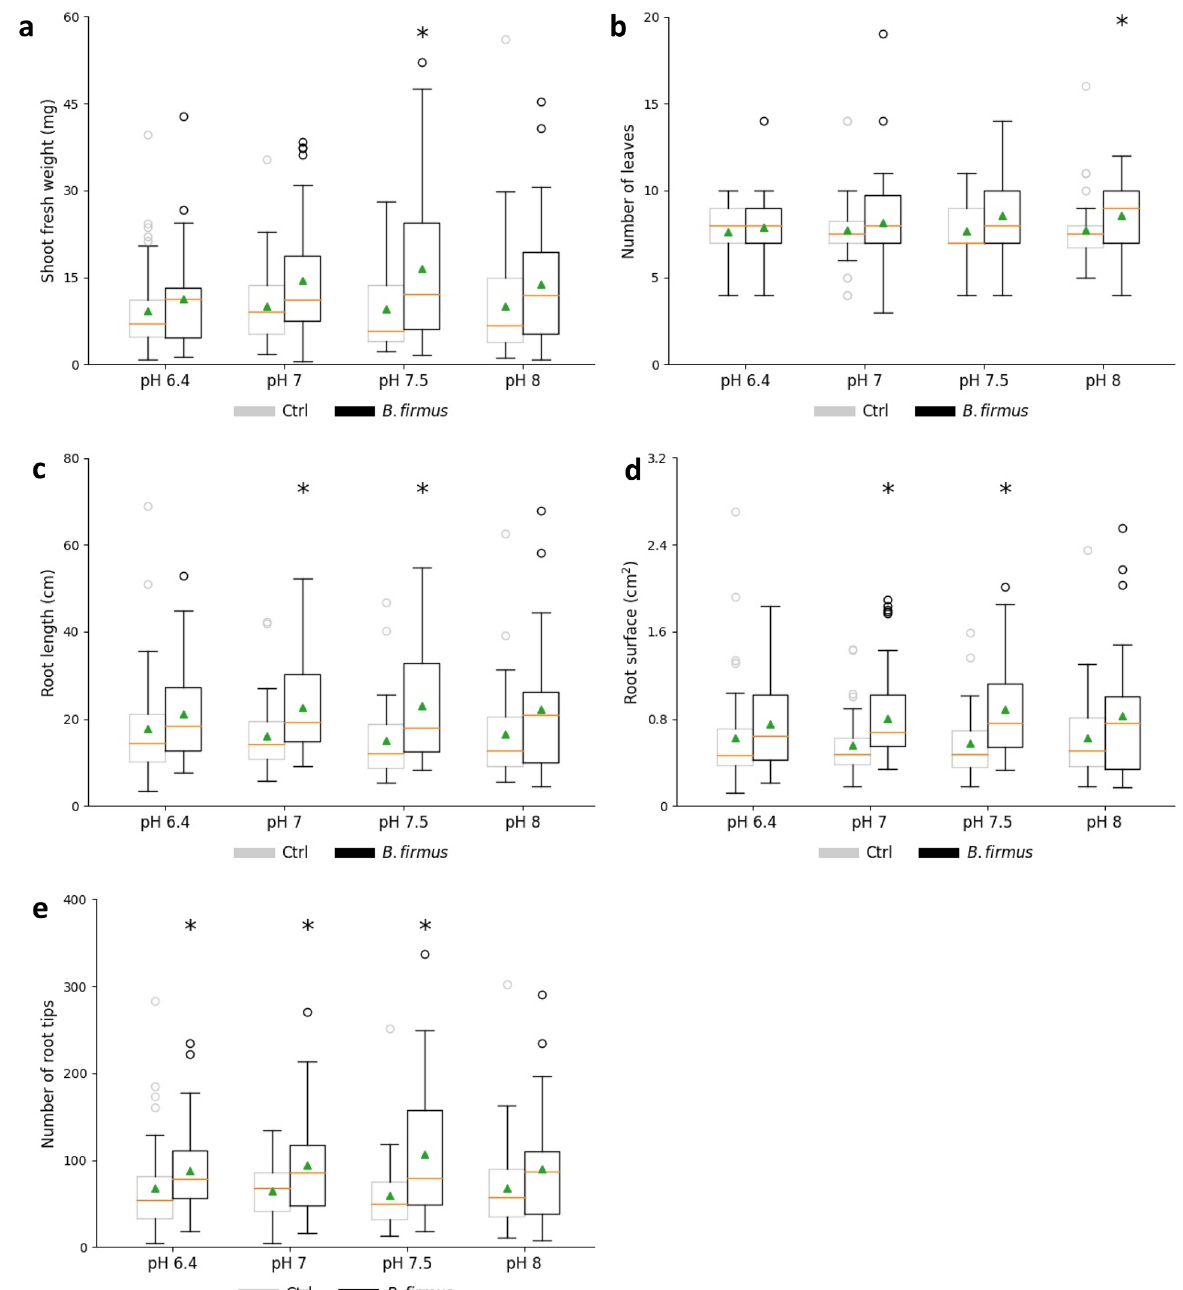
Figure 3. Impact of pH and Bacillus firmus I-1582 inoculation on Arabidopsis thaliana development. Average shoot fresh weight ( a ), average number of leaves ( b ), average total root length ( c ), average root surface ( d ), average number of root tips ( e ) per plant. Results are expressed as the mean (orange line) and median (green triangle) ± standard error of three independent biological replicates (n ≥ 31). Ctr control. Data are statistically analysed using Dunn’s Method. Asterisk (*) indicate statistically significant differences compared with the control ( p <